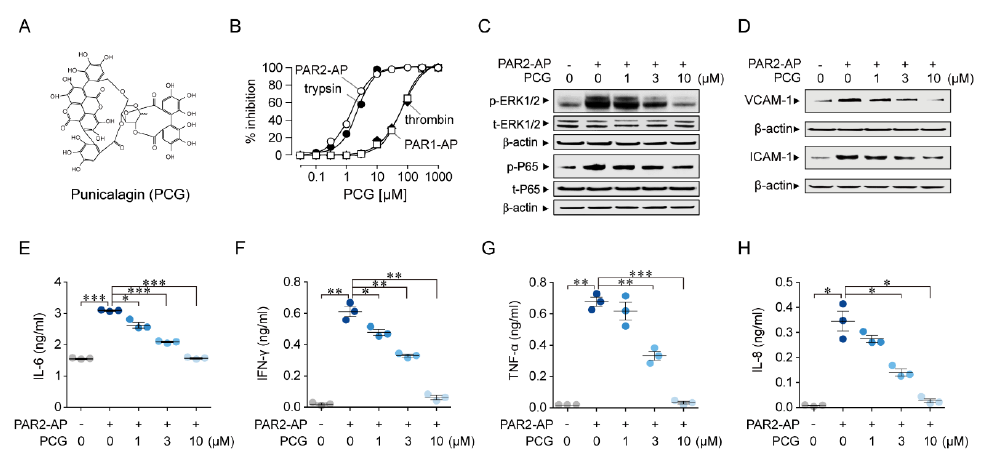
Figure 1. Characterization of punicalagin, a novel PAR2 antagonist, in the human podocyte cell line. ( A ) Chemical structure of punicalagin (PCG). ( B ) Summary of dose responses (mean ± SEM, n = 5–6). ( C ) Western blot analysis of phospho-ERK1 / 2 (p-ERK1 / 2), total ERK1 / 2 (t-ERK1 / 2), phospho-P65 (p-65) and total P65 (t-p65). The indicated concentrations of PCG were applied 30 min prior to PAR2 activation by PAR2-AP. ( D ) Inhibition of the PAR2-induced upregulation of VCAM-1 and ICAM-1 by PCG. VCAM-1 and ICAM-1 expression levels were detected at 6 h after PAR2 activation. ( E – H ) The indicated concentrations of PCG were applied 30 min prior to the application of PAR2-AP. IL-6, IFN- γ , TNF- α , and IL-8 concentrations were measured at 12 h after PAR2 activation (mean ± SEM, n = 3). * p < 0.05, ** p < 0.01, and *** p < 0.001. Two-tailed Student’s t -test ( E , F ).